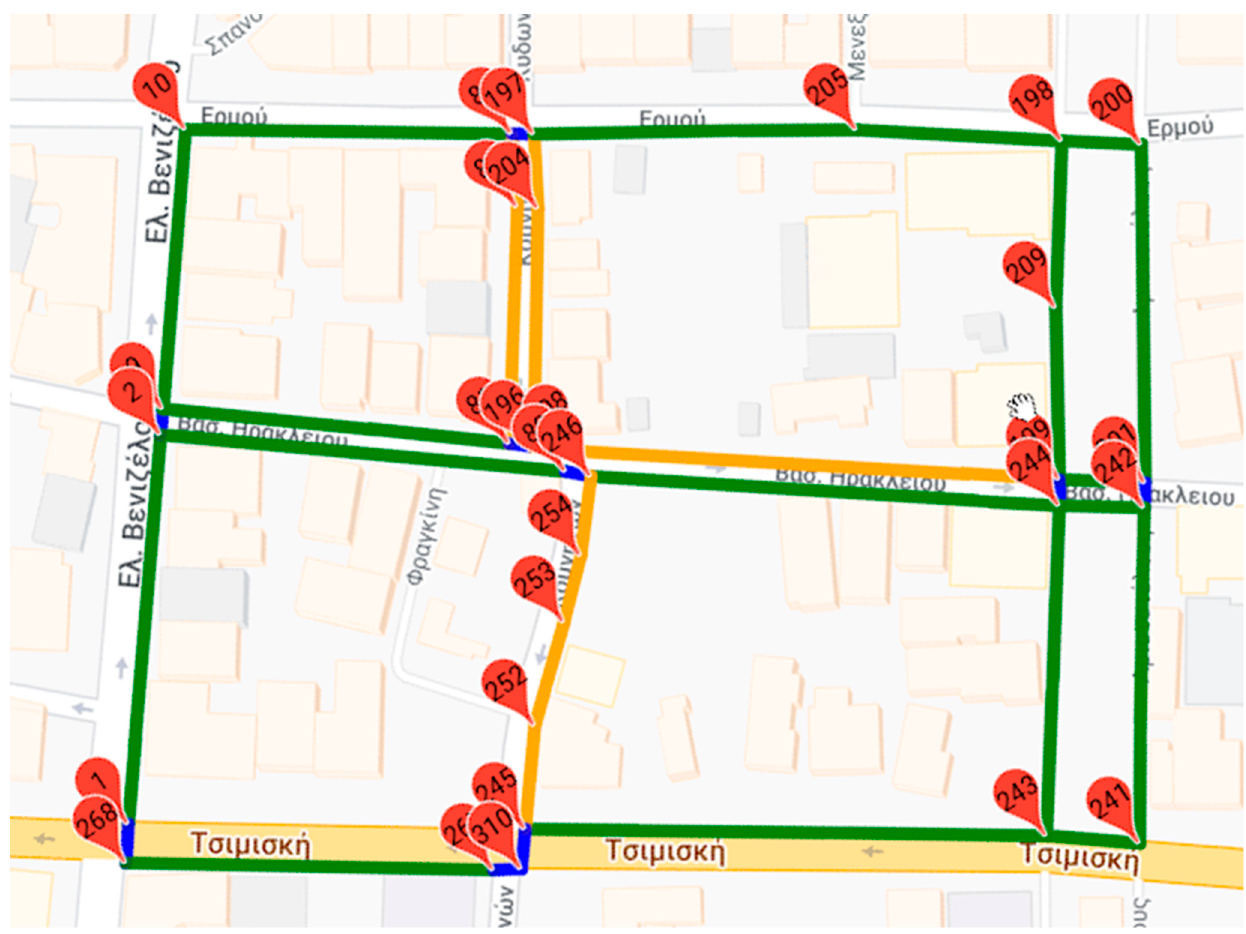
Figure 1. Use case I graph dataset.